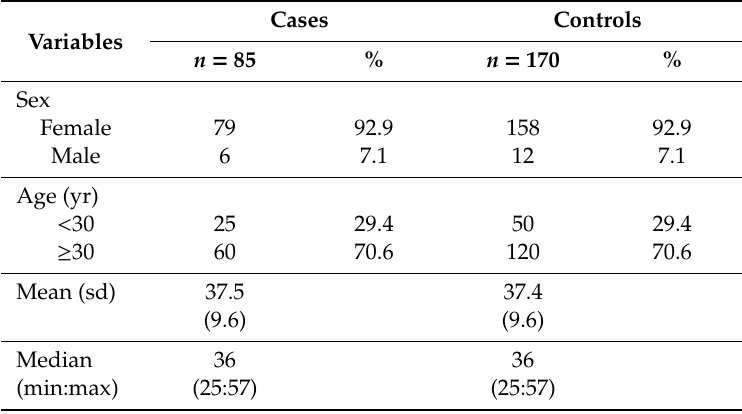
Table 1. Outcome of case-control matching procedure.